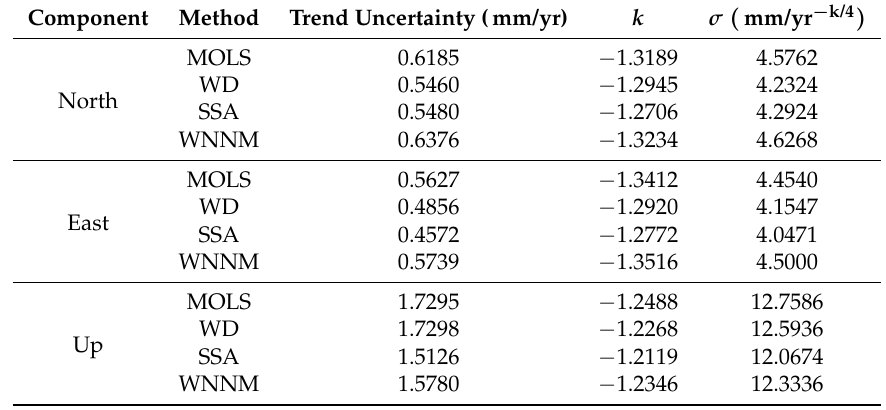
Table 9. Mean results of the trend uncertainty, spectral indices and noise amplitudes estimated from a set of nine stations.